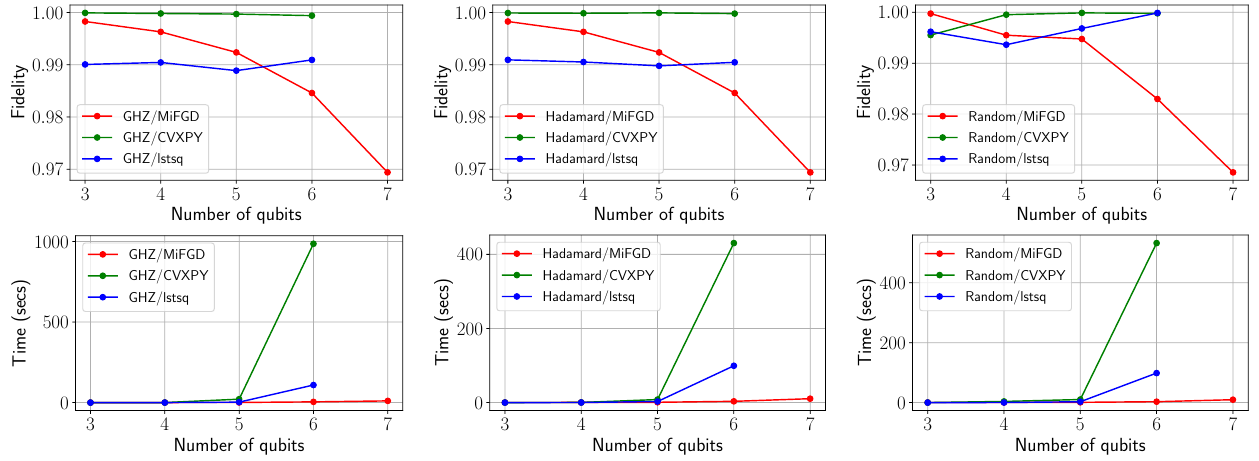
Figure 5. Fidelity versus time plots using synthetic IBM’s quantum simulator data. Left panel : ( n ) for n = 3,4; Middle panel : Hadamard ( n ) for n = 3,4; Right panel : Random ( n ) for GHZ − − − n = 3,4. Table 3. Fidelity of reconstruction and computation timings using 100% of the complete mea- surements. Rows correspond to combinations of number of qubits (7 8), synthetic circuit, and ∼ tomographic method ( MiFGD , Qiskit’s lstsq and CVXPY fitters. 2048 shots per measurement circuit. For MiFGD , η = 0.001, µ = 3 , reltol = 10 − 5 . All experiments are run on a 13” Macbook Pro 4